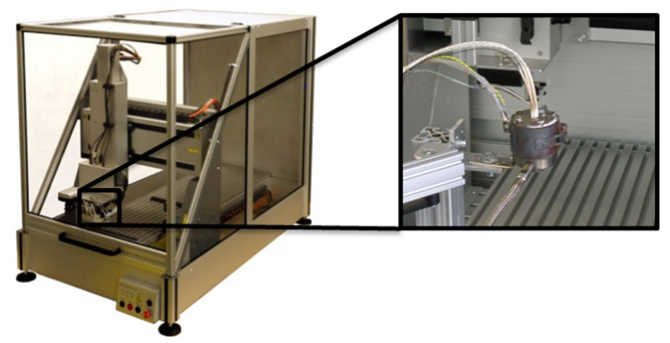
Figure 4. iBiospot ® 600 (reference image) from BioFluidix GmbH with mounted StarJet printhead